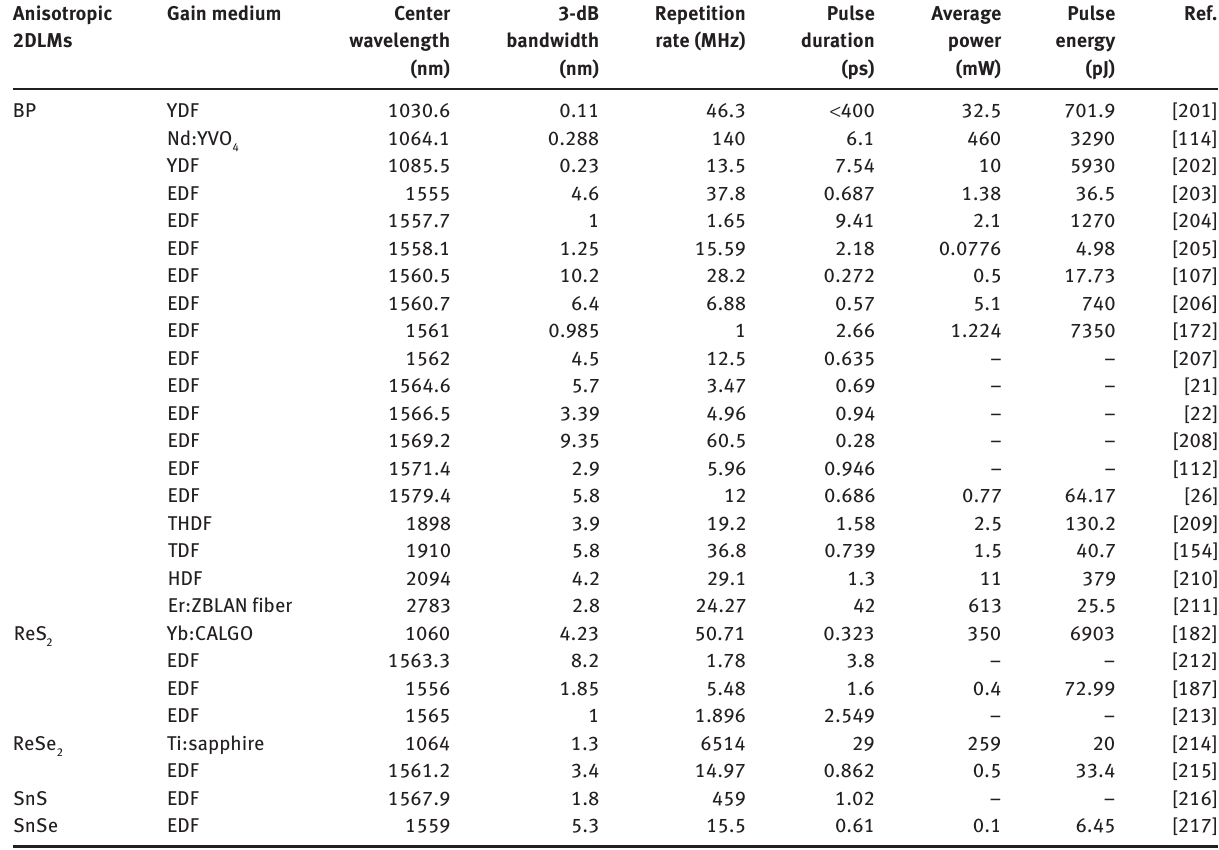
Table 3: Summary of mode-locked lasers with anisotropic 2DLMs.